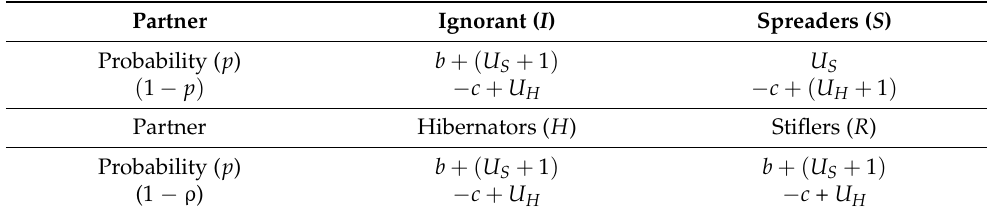
Table 3. A payoff matrix for information